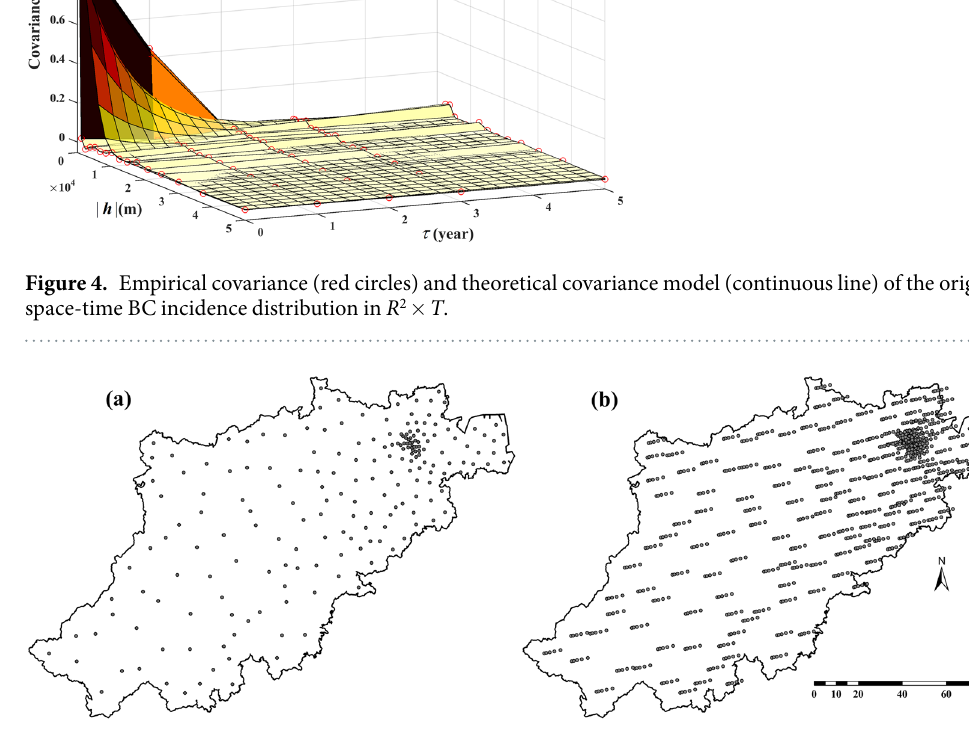
Figure 5. ( a ) Distribution of original BC incidence locations s in Hangzhou and ( b ) distribution of BC   s after coordinate transformation υ = − s s t . Maps were generated using ArcGIS 9.3. incidence location